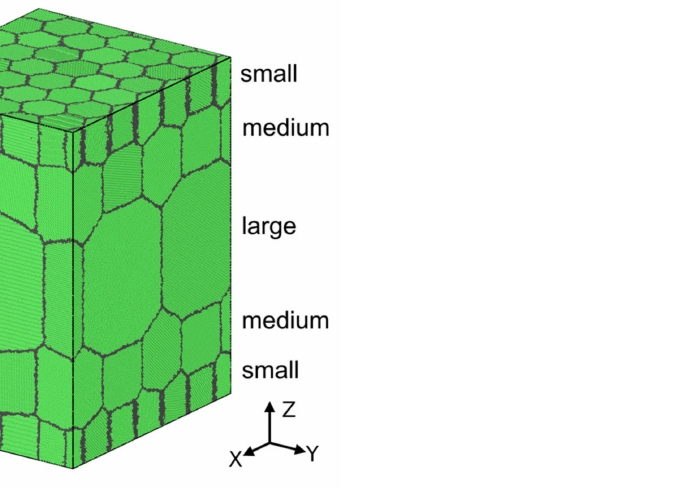
Figure 1. The initial structure of the gradient nanograined FeNi sample. Atoms with fcc nearest neighbor symmetry are highlighted in green; grain boundary (GB) atoms are shown in